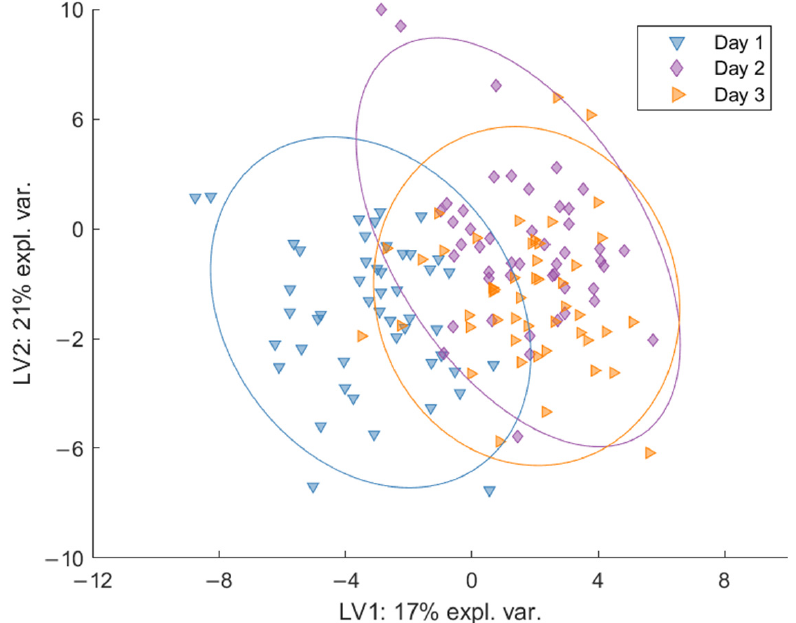
Figure 3. M-PLS-DA model for St0 for all post walking measurements (Day 1, Day 2, and Day 3) with a difference in clustering along the first latent variable (LV1). There is high overlap between Day 2 and Day 3 and a degree of separation between Day 1 and the other time points on LV1, suggesting a possible adaptation to prolonged exercise after the 2nd and 3rd day of walking.